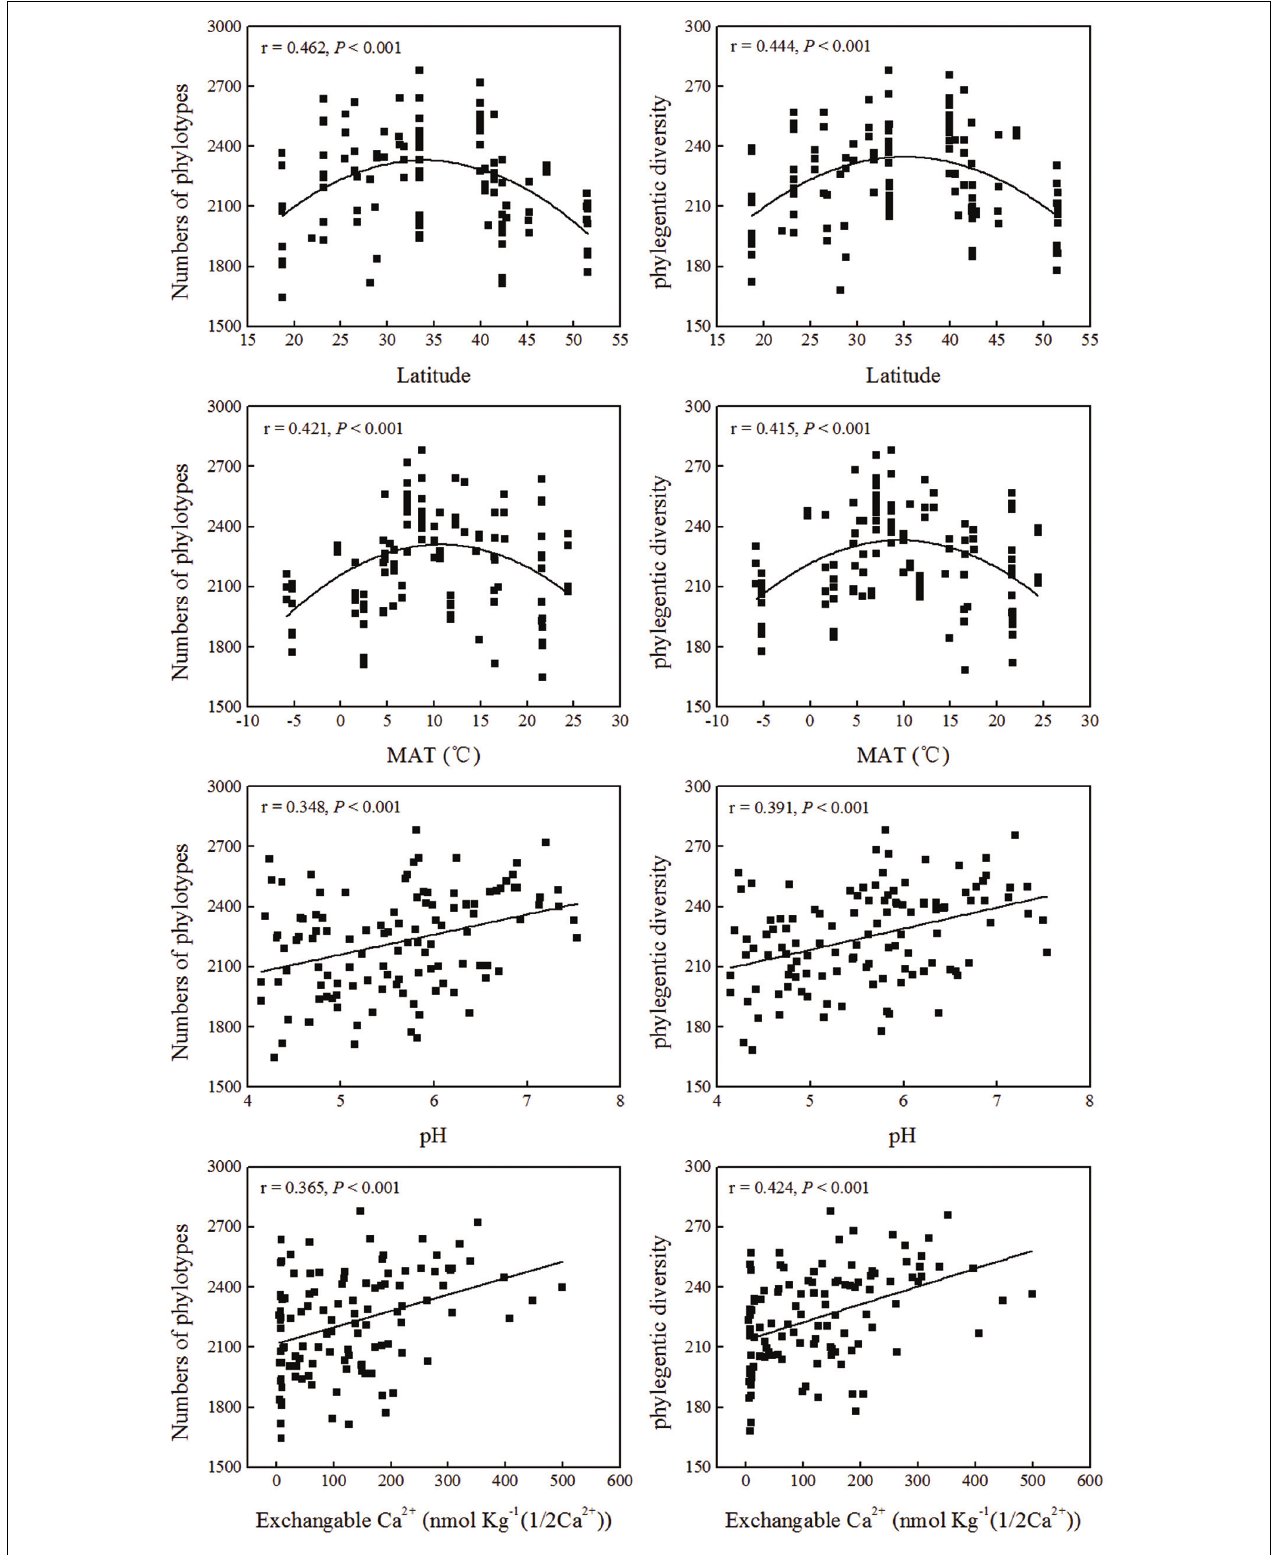
FIGURE 4 | Relationship between soil bacterial diversity indices (phylotypes and phylogenetic diversity) and soil location, or soil physical and chemical properties.